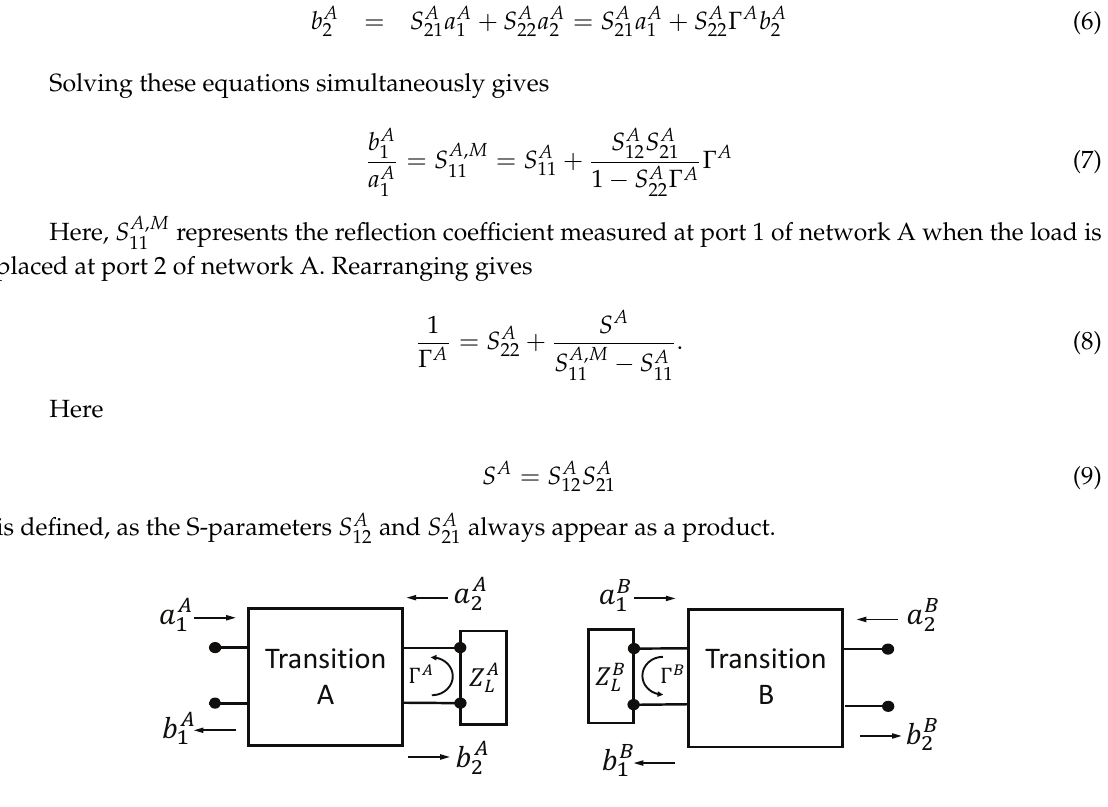
Figure 4. Termination of transition networks with known